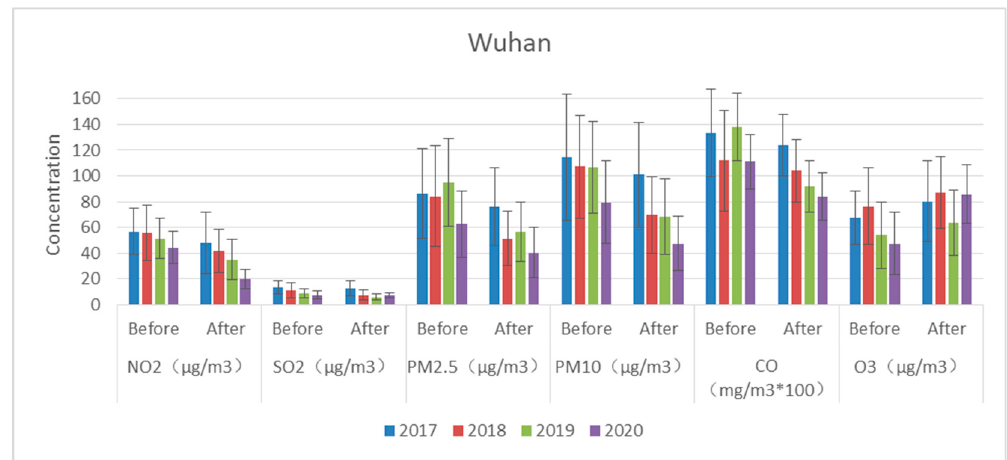
Figure 6. Mean and standard deviation for 30 days before and 30 days after the Spring Festivals in the years 2017–2020, for NO 2 , SO 2 , PM 2.5 , PM 10 , CO, and O 3 in Wuhan.